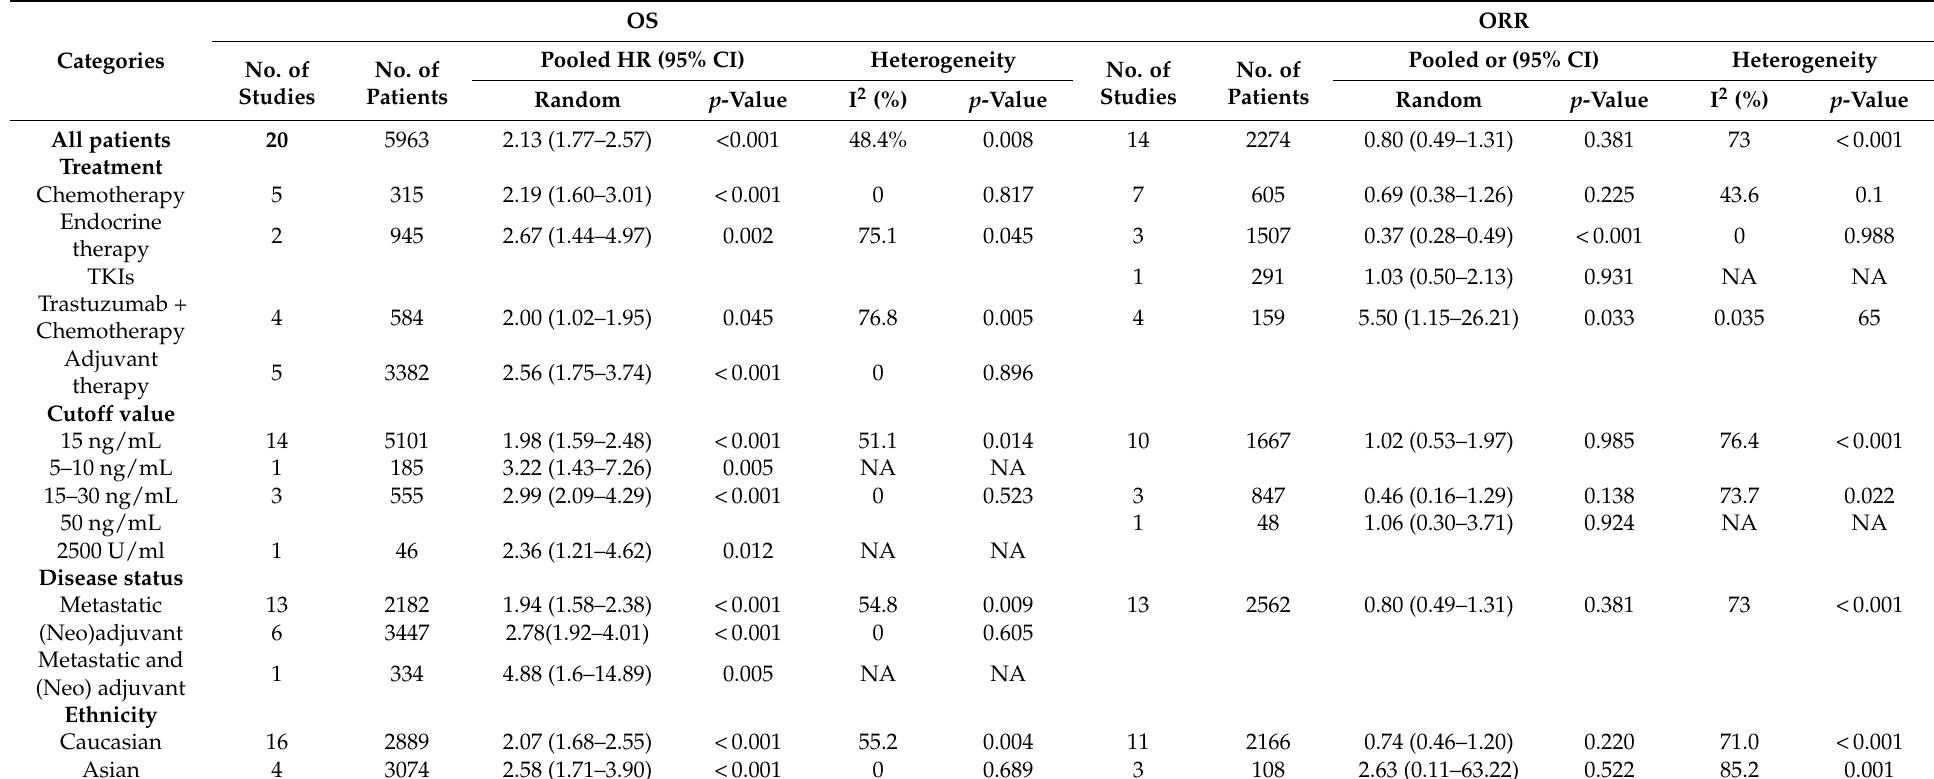
Table 3. Subgroup analysis of the pooled HR/OR for the OS and